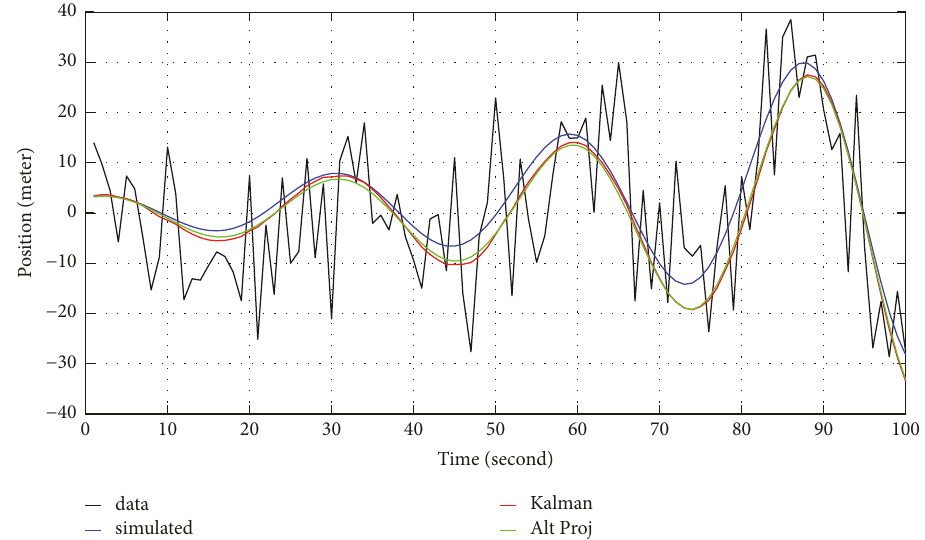
Figure 1: Tracking of moving objects: simulated positions in blue, noisy measurements of positions in black, Kalman filter (KF) recovering of positions in red, and Alternating Projections Filter (APF) recovering of positions in green. Running CPU times of both algorithms depend on the size 𝐽 and the size of time step Δ𝑡 . As 𝐽 increases and/or Δ𝑡 decreases, time of both APF and KF increases; however APF is much faster than KF. Indeed, APF is over 25 times faster than KF with size 𝐽 = 2000 of the unknown state vector and time step Δ𝑡 = 0.05 s over 100